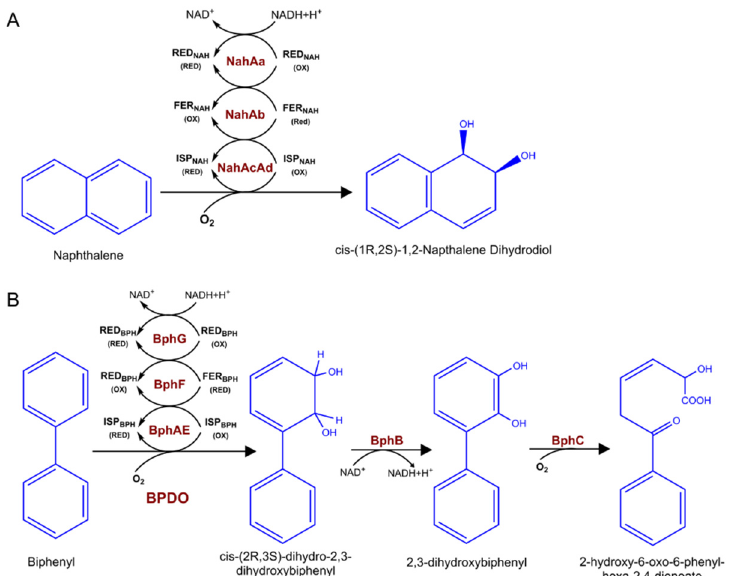
Figure 2. Naphthalene and biphenyl catabolic pathway enzymes and metabolites. ( A ) Naphthalene catalyzed by three-component NDO to cis-(1R,2S)-1,2-napthalene dihydrodiol. ( B ) The four enzymatic steps of the bacterial biphenyl metabolic pathway catalysis by BPDO. red, reduction; ox, oxidation.